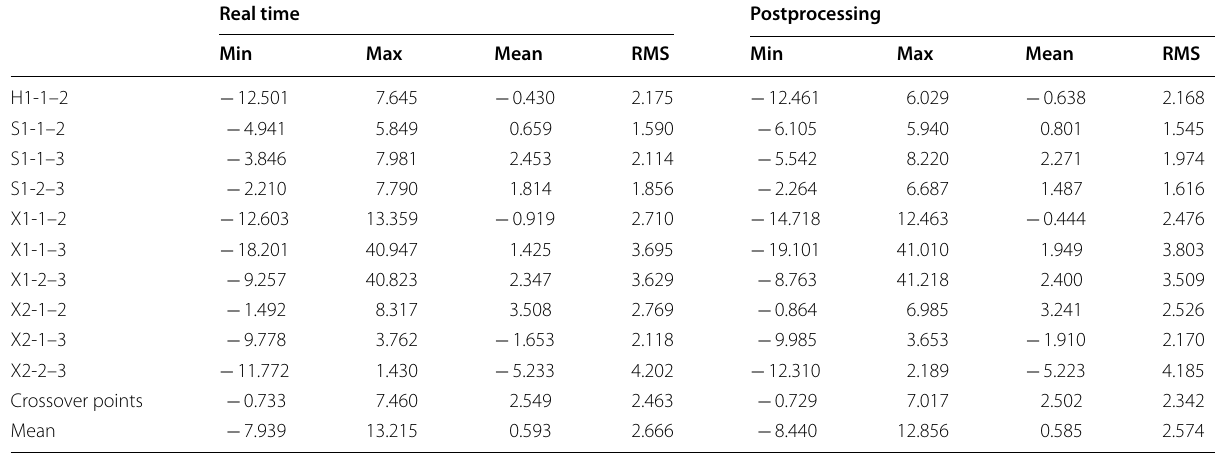
Table 8 Statistical results of L&R